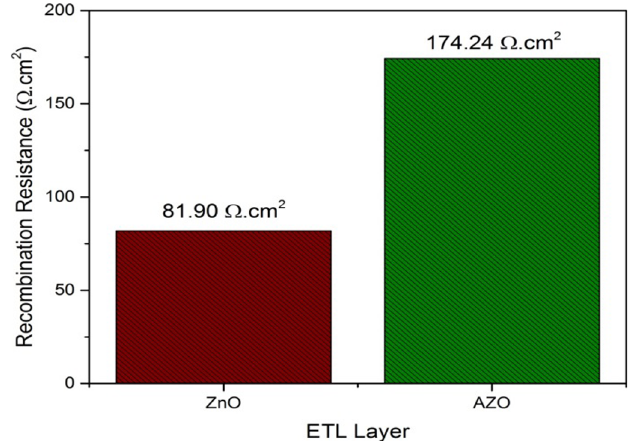
Fig. 2. J – V characteristics of MA 0.6 FA 0.4 PbI 3 perovskite/ZnO and MA 0.6 FA 0.4 PbI 3 perovskite/AZO devices at room tempera- ture.